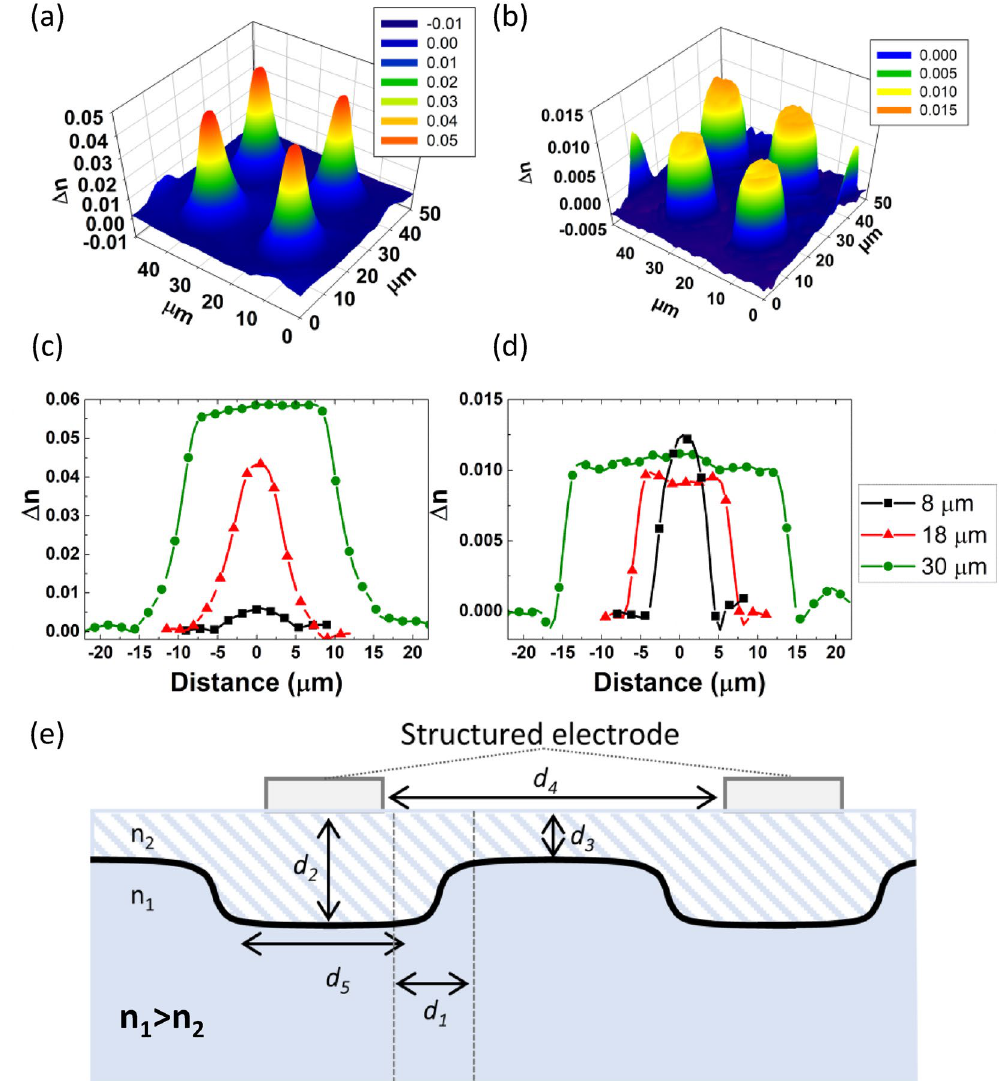
Figure 4. Phasics map at λ = 750 μ m of 18 µ m spots imprinted on a chalcogenide ( a ) and soda lime glass ( b ) subjected to identical poling voltages; Δ n profiles measured across circles 8, 18 and 30 µ m wide on a chalcogenide ( c ) and soda lime glass ( d ); principle parameters controlling the gradient of index geometry in the glass after thermal poling ( e